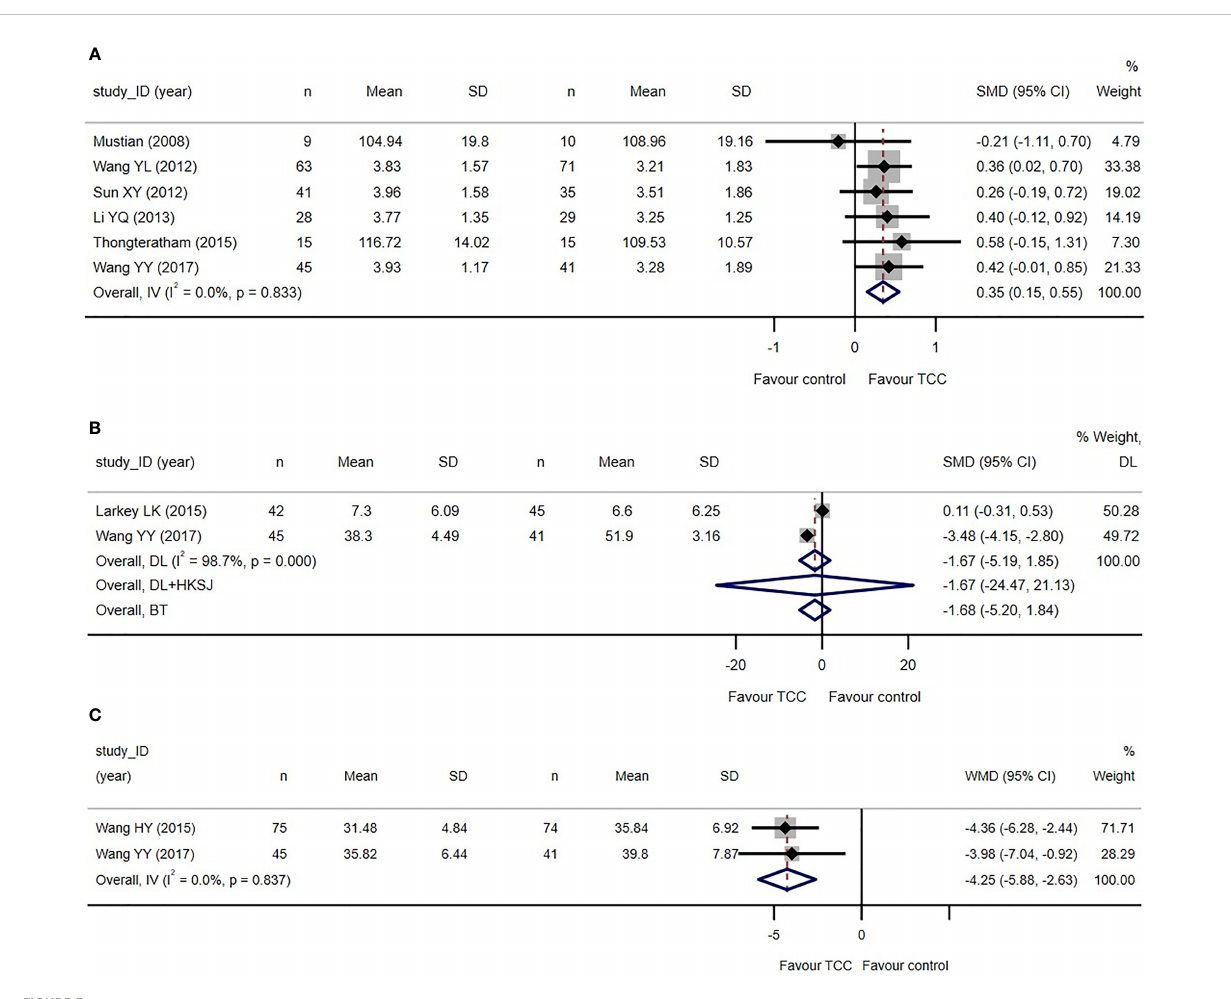
FIGURE 3 Primary outcomes of the systematic review of Tai Chi Chuan training on the QoL and psychological well-being in female patients with breast cancer. (A) TCC-based exercises are superior to the controls on quality of life. (B) No difference between TCC-based exercises and the controls on depression. (C) TCC-based exercises are superior to the controls on anxiety. The weights of trials were provided by random effect model applying DL tau 2 estimator. BT, Biggerstaff – Tweedie approximate Gamma model; DL, DerSimonian – Laird estimator of tau 2 ; DL+HKSJ, Hartung – Knapp-Sidik – Jonkman (HKSJ) variance correction to DerSimonian – Laird estimator of tau 2 ; IV, fi xed effect inverse variance; SD, standard deviation; SMD, standardized mean difference; TCC, Tai Chi Chuan; IV, fi xed effect inverse variance. The study ID consists of the fi rst author ’ s surname, the